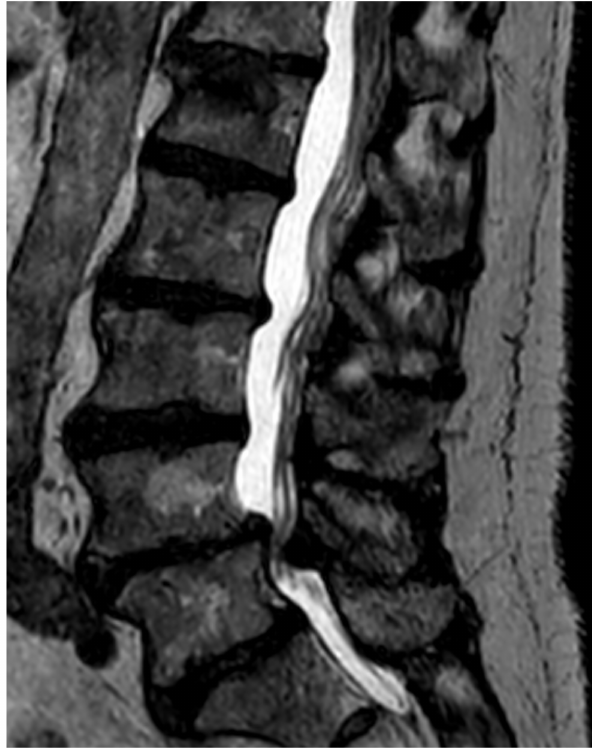
Figure 1. Typical sagittal T2 sequence of a lumbar MRI with signal-attenuated and reduced-height intervertebral discs, evidence of multisegmental disc bulging and degenerative spinal stenosis in segment L4/L5. Additionally, typical vertebral haemangioma at